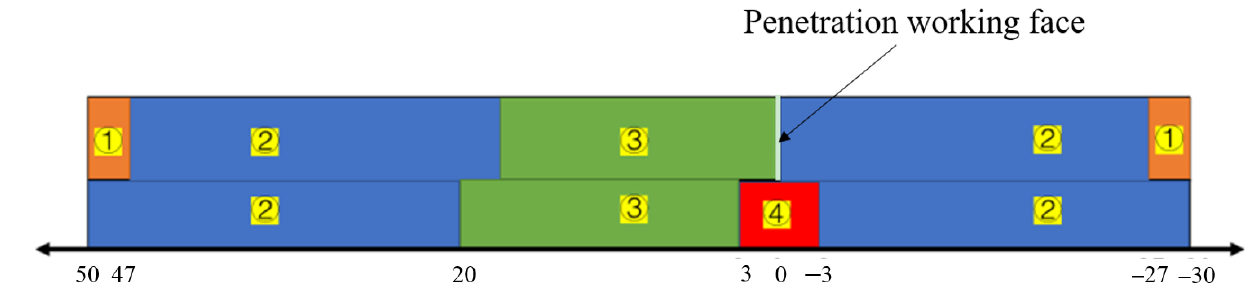
Figure 8. Photos of two stages of the excavation at the site: ( a ) #58 right tunnel working face; ( b ) #59 right tunnel working face.